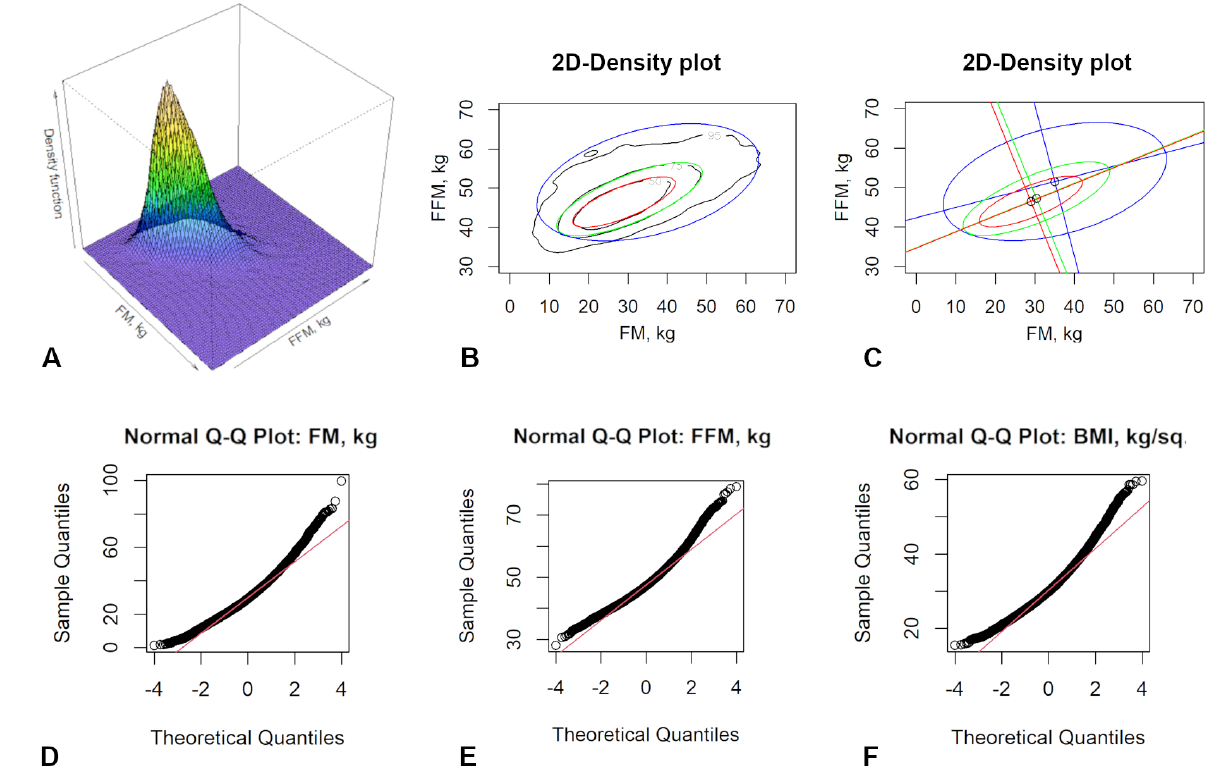
Fig. 3. Visual representations of the two-dimensional density distribution of Fat mass and Fat free mass (A-C) and normal quantile-quantile plots (D- F) in 57-year-old women (data for 15,434): A. a three-dimensional graph of the density distribution, B. flat sections containing inside 50%, 75% and 95% of data (black lines are sections obtained directly from the data, colored lines are calculated ellipses), C. axes and centers of tolerance ellipses, D. a normal quantile-quantile plot of Fat mass, E. a normal quantile-quantile plot of Fat free mass, F. a normal quantile-quantile plot of Body mass